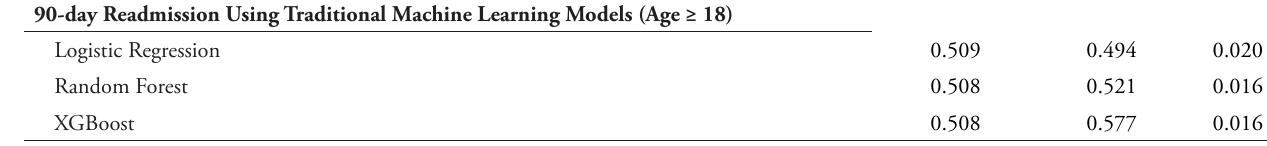
Abbreviations: AUC, area under the receiver operating characteristic